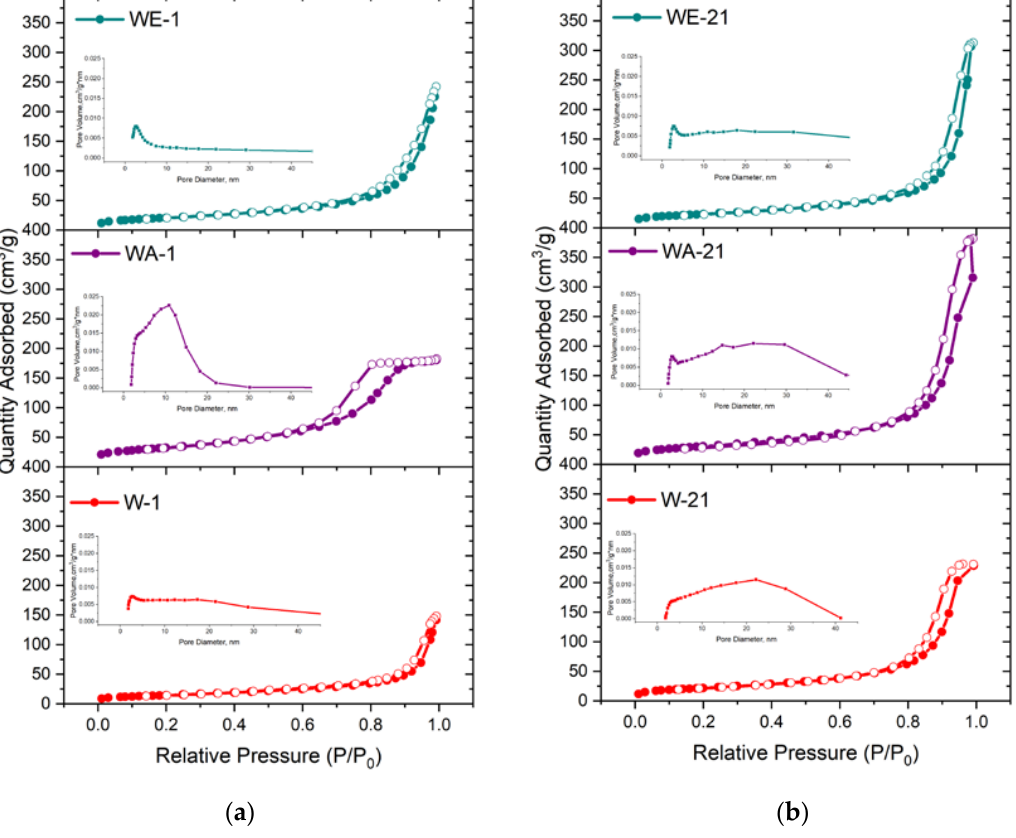
Figure 6. Nitrogen adsorption–desorption isotherms and BJH pore-size distributions of the as-synthesized powders ( a ) and those data after 21 days of ripening ( b ).